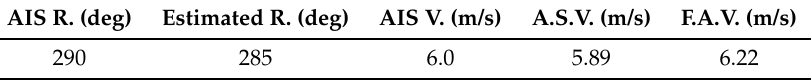
Table 1. Kinematics estimation output. R. stands for Route and V. for Velocity. The presented velocity results correspond respectively to the Azimuth Shift (A.S.V.) method and to the Fourier Analysis method